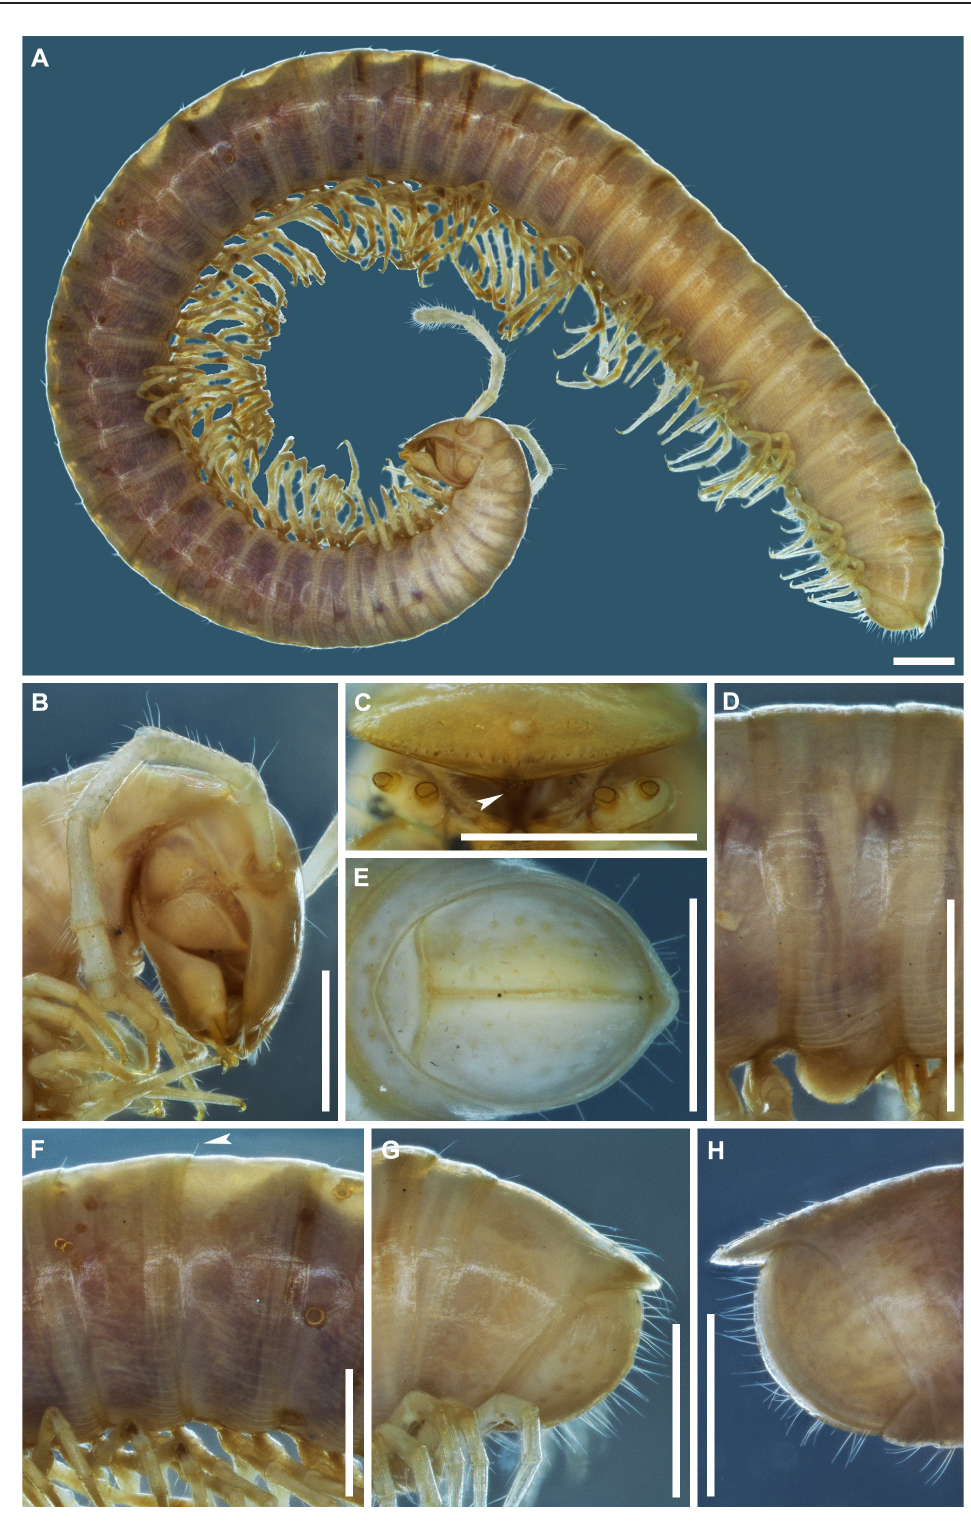
Fig. 11. Leucogeorgia rediviva Golovatch, 1983 (A–G: ♂ from Novoafonskaya Cave (ZMUM); H: ♂ from Snezhnaya Cave (ZMUM)). A . Habitus, lateral view. B . Head, lateral view. C . Head, anterior view. D . Body ring 7, lateral view. E . Telson, posterior view. F . Midbody rings, lateral view. G . Telson, lateral view. H . Telson, lateral view. Arrows indicate three reduced labral teeth on C, or metazonal setae on F. Scale bars: 1